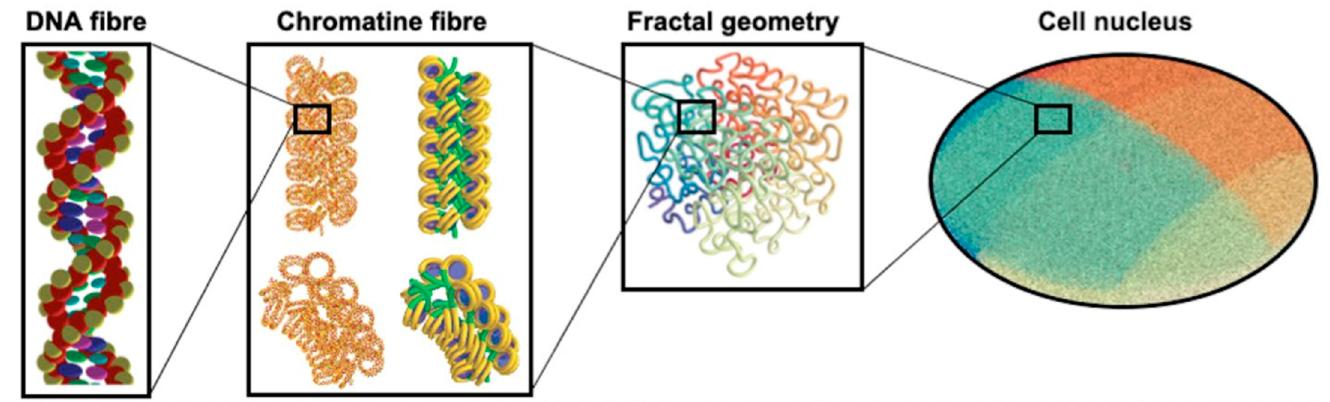
Figure 7. The structure of cell nucleus and its sub-biological components for the molecularDNA application [127].